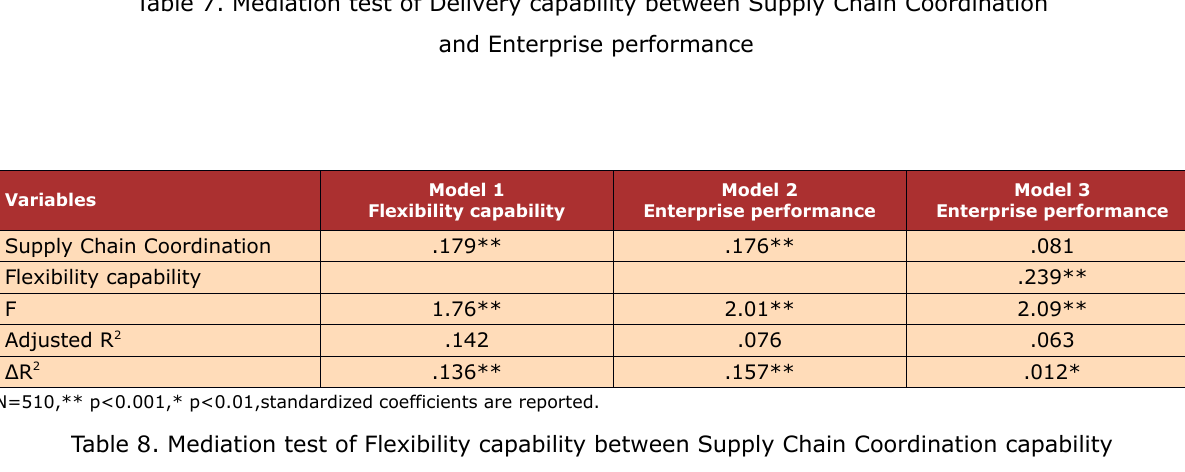
Table 8. Mediation test of Flexibility capability between Supply Chain Coordination